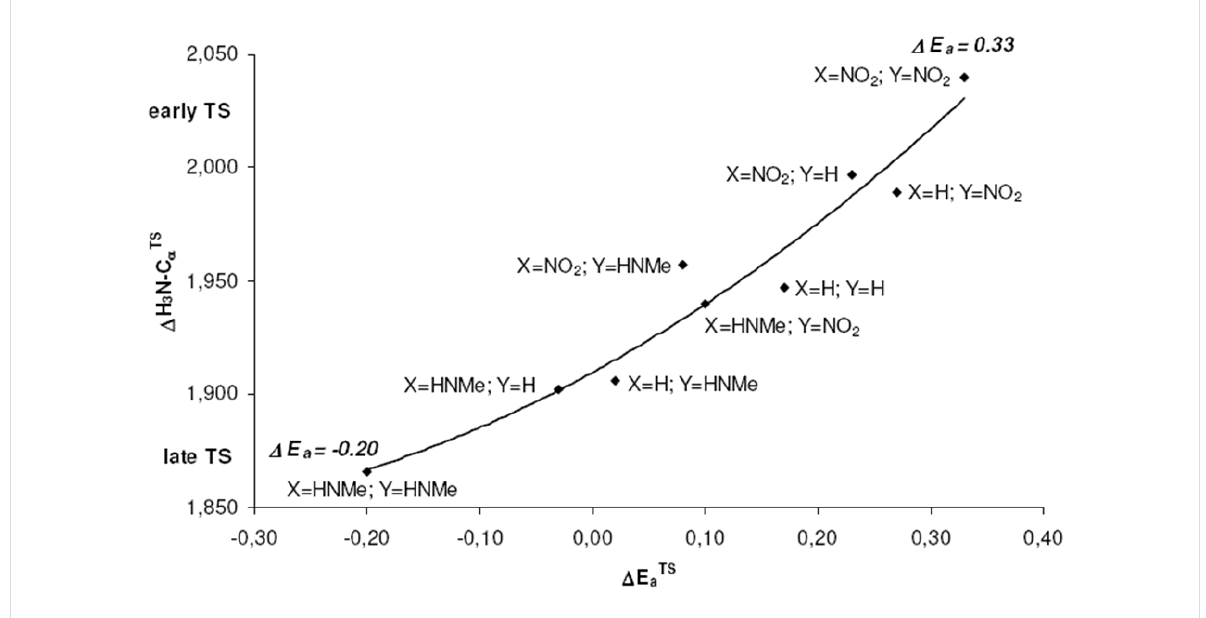
Figure 10: Higher site selectivities, i.e. larger ΔE aTS values, are found for earlier transition structures with larger H 3 N-C α distances.